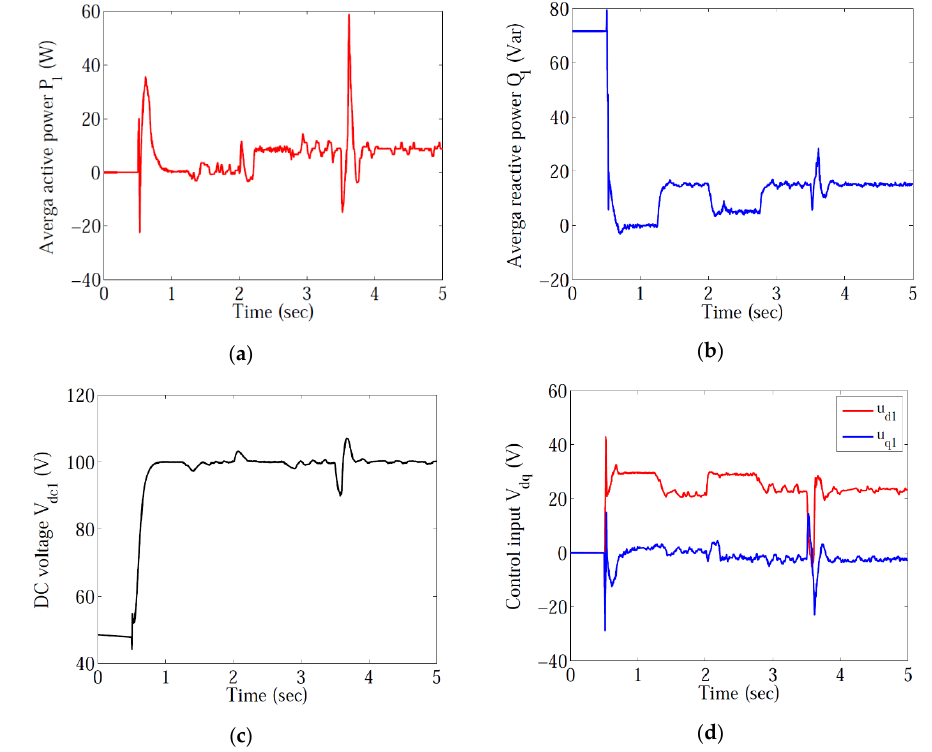
Figure 7. System responses obtained in the rectifier controller experiment: ( a ) Average active power 𝑃 1 ; ( b ) average active power 𝑄 1 ; ( c ) DC voltage 𝑉 dc1 ; ( d ) control input 𝑉 dq .